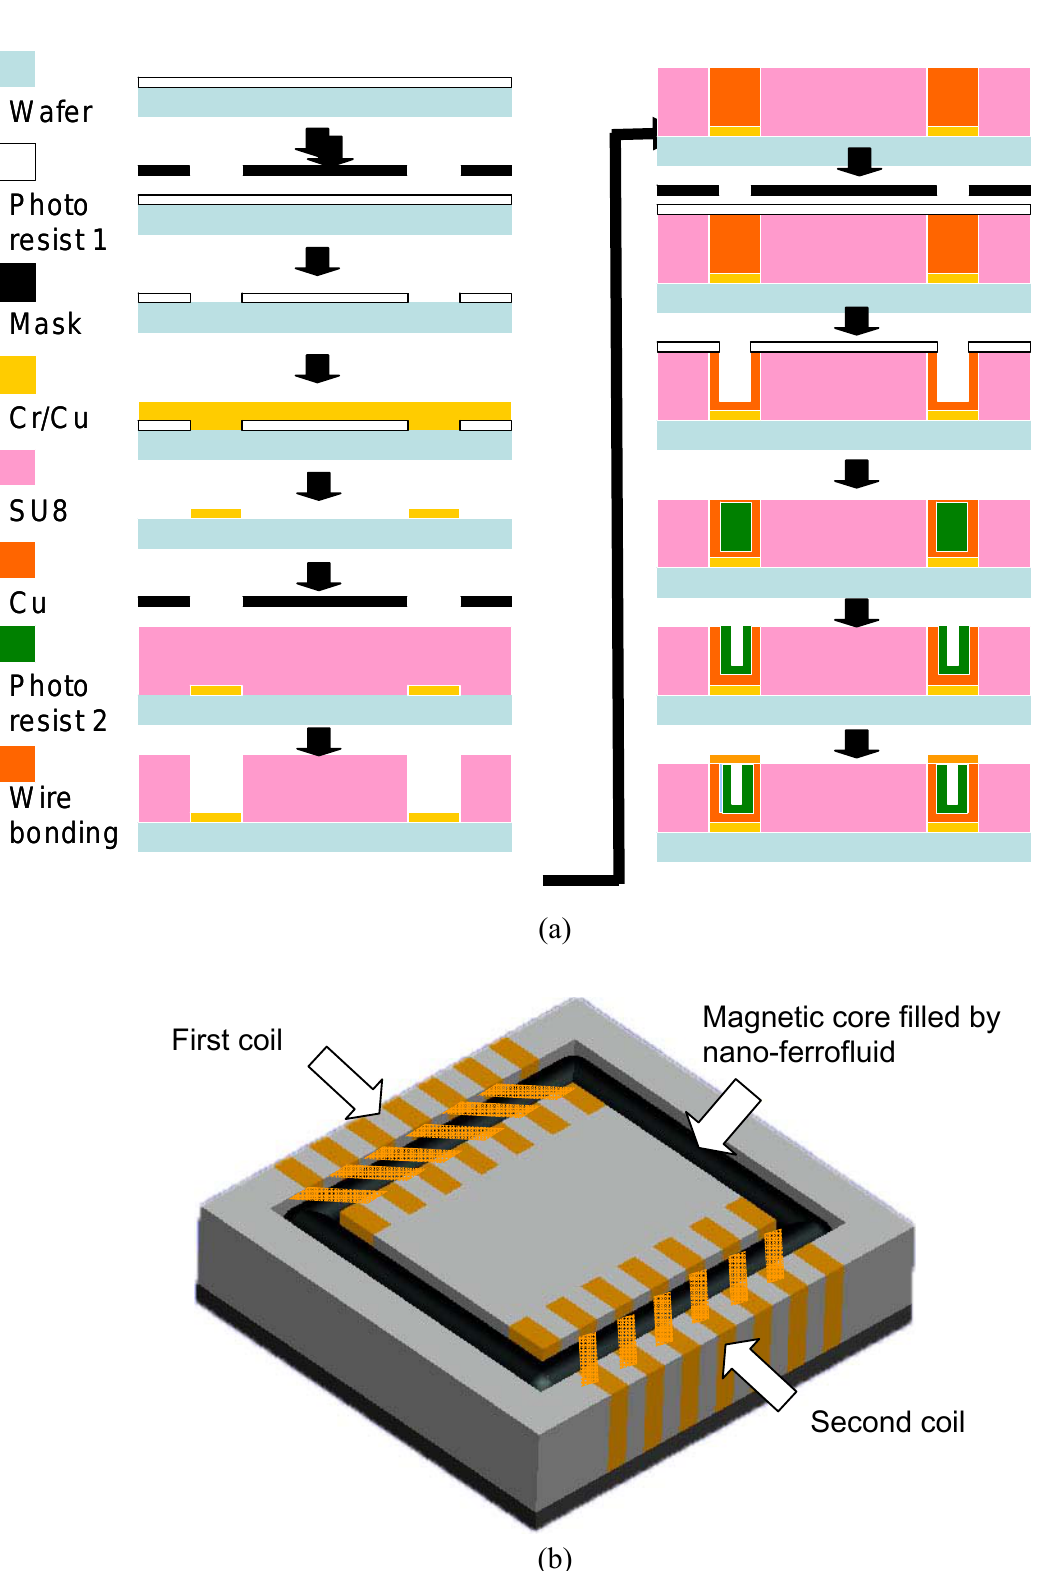
Figure 2. Post MEMS processes for manufacturing the energy harvesting chip (a) and the schematic view of the micro-structured transformer with the magnetic core filled by nano-